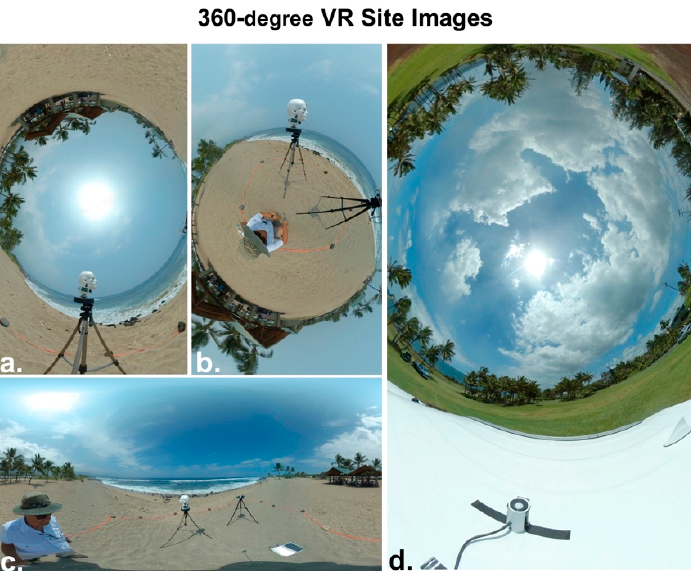
Figure 16. The three virtual reality (VR) images at left ( a – c ) were made at the Old Kona Airport Park. They show the entire sky and the trees, ground and surf surrounding the rotating mannequin head and the PMA1102 sensor. The VR image at right ( d ) shows the sky and landscape at Seaside Estates Park on 5 August 2018, the day Fissure 8 of the Kilauea volcano ceased erupting. The UVR from the sun and sky in this image was being measured by the rotating mannequin head and the PMA1102 UV sensor in the foreground, which is mounted atop the project’s rental car.